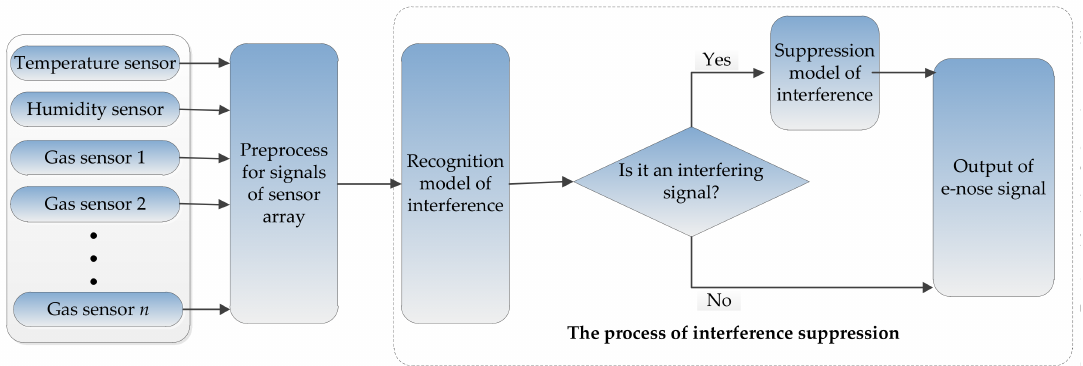
Figure 5. Structure of the idea for suppressing the dynamic